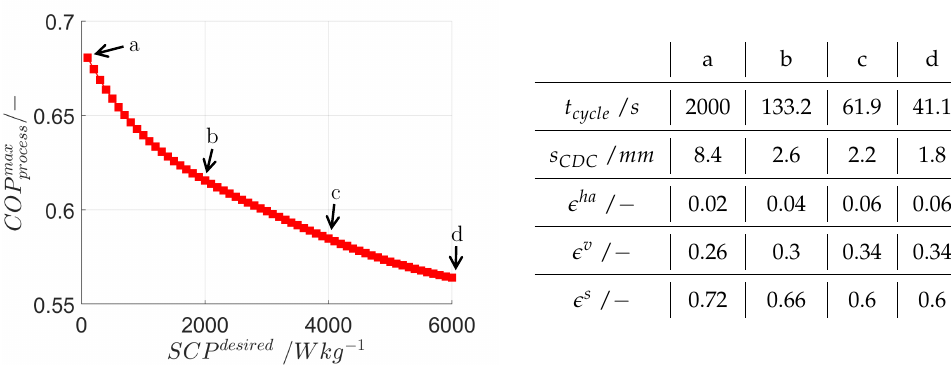
Figure 14. Optimal design layout for different desired values of SCP with corresponding optimal cycle time, layer thickness and material